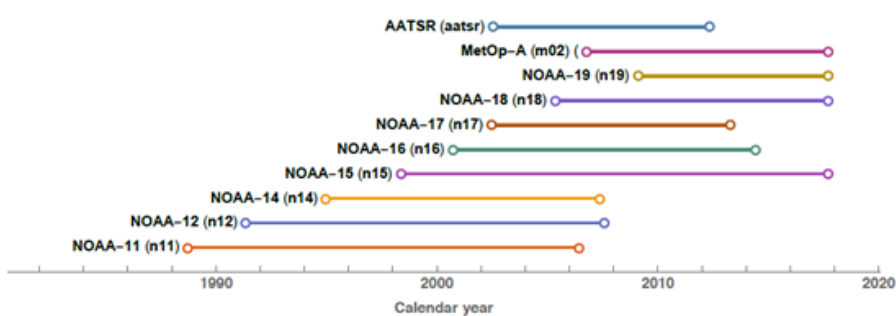
Figure 2. Timeline of NOAA and MetOp satellites acquisition overlapping in time for harmonization purposes [48].